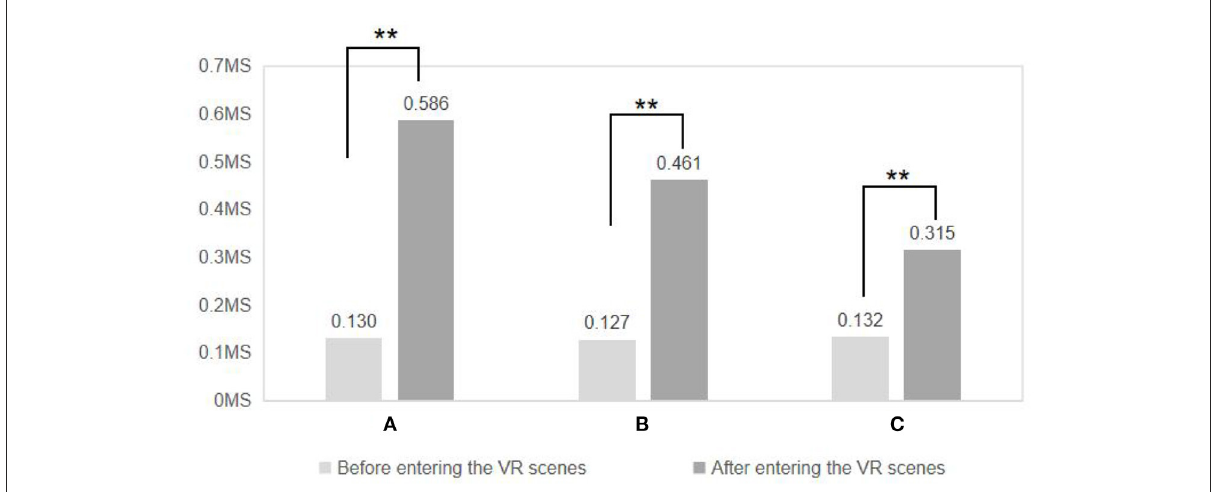
FIGURE8 Comparison of the difference in tare values before and after the experience of three VR scenes. N = 48; mean ± SD; ** P < 0.01; verified by paired t -test.